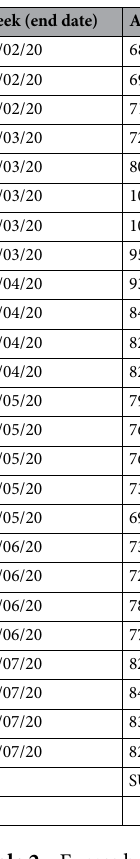
Table 2. Excess headache occurrences (proxied by web-search queries): February 2020–July 2020, 25